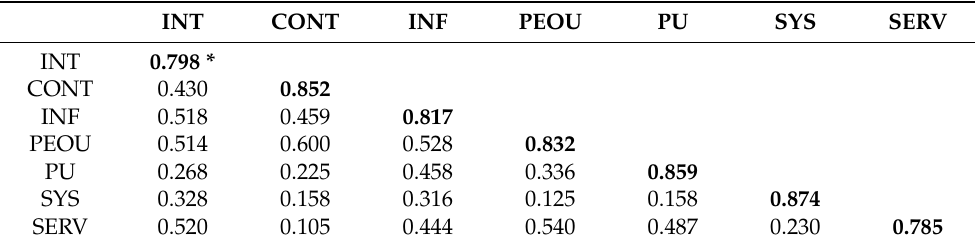
Table 5. Fornell–Larker Scale.